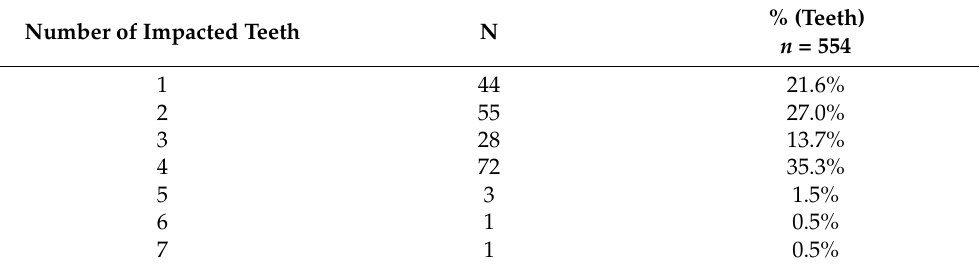
Table 1. Number of impacted teeth in study group patients.